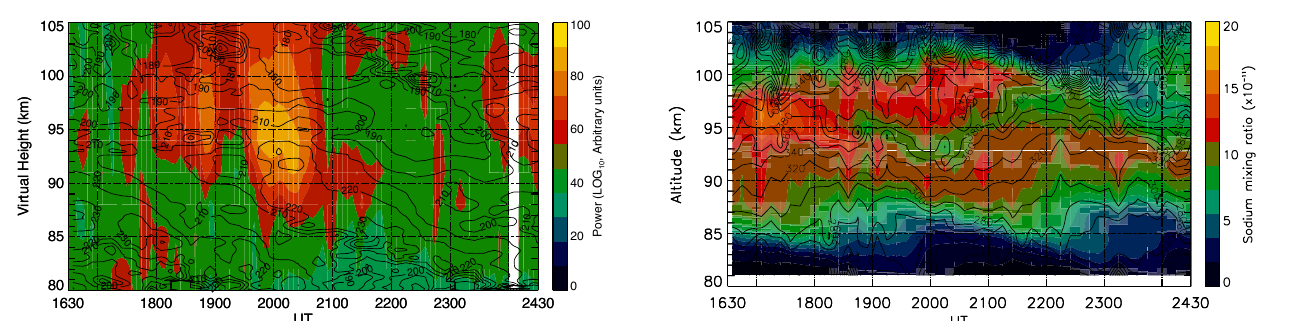
Figure 9. The color contours show the sodium mixing ratio ( × 10 − 11 ) on 29 October 2010. The black lines are contours of the potential temperature (K). The sodium mixing ratio shows a double peak structure be- tween 18:00 and 21:30 UT. An overturning in the sodium al- titude profile should indicate that a wave is breaking or is about to break (Hecht, 2004). Possible causes of overturning features of the sodium density between 95 and 105 km were discussed by Larsen et al. (2004). Though the causes are still not well understood, an overturning is a common character- istic of Kelvin–Helmholtz instabilities associated with large shears or the manifestation of GW breaking (Larsen et al.,